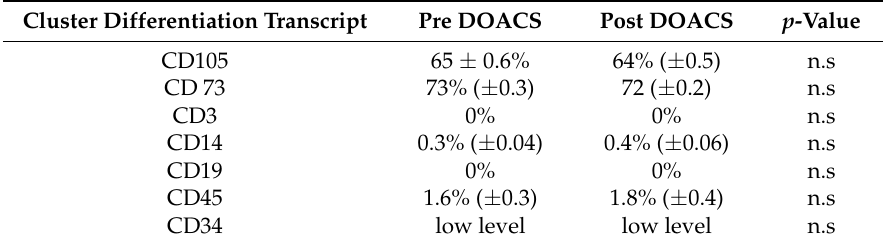
Table 4. Cluster differentiation (CD) markers expression was similar in circulating progenitors harvested before and after three months of DOAC treatment. n.s (not statistically significant).